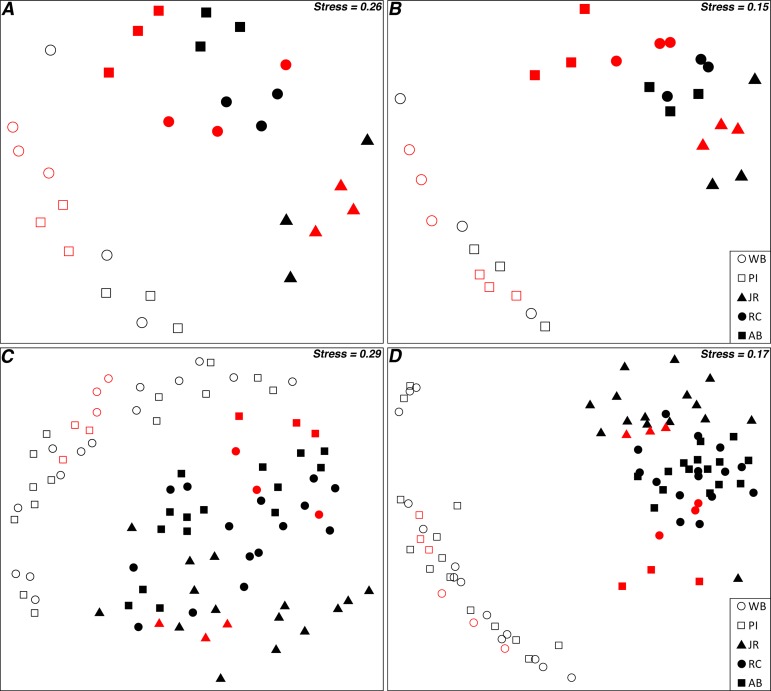
nMDS ordination plots of transplant samples and controls.(A) All 16S rRNA gene OTUs for control samples; (B) Top 10 most abundant 16S rRNA gene OTUs for control samples; (C) All 16S rRNA gene OTUs for all samples; and (D) Top 10 most abundant 16S rRNA gene OTUs for all samples. “Red” symbols are pristine control samples, “black” are transplant samples. Transplant samples are labeled by origin site.